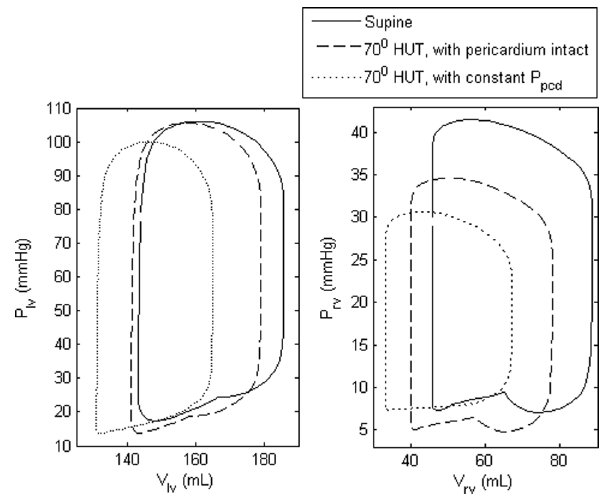
Figure 7. LV (left) and RV (right) pressure volume (PV) loops. LV and RV PV loops during supine and 70 o HUT for the heart failure condition, with (i) pericardium intact and (ii) constant pericardial pressure ( P pcd